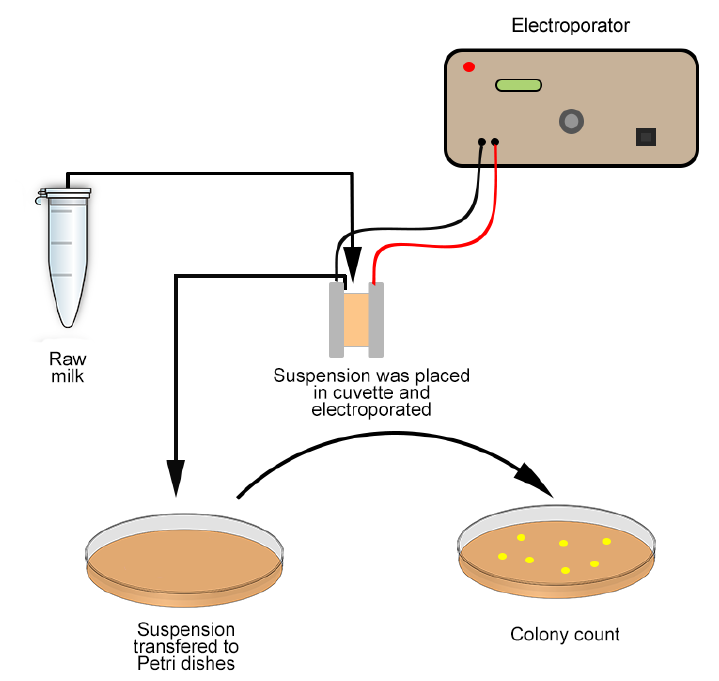
Figure 2. Schematics of an experiment to determine bacterial activity in raw milk samples after PEF treatment.